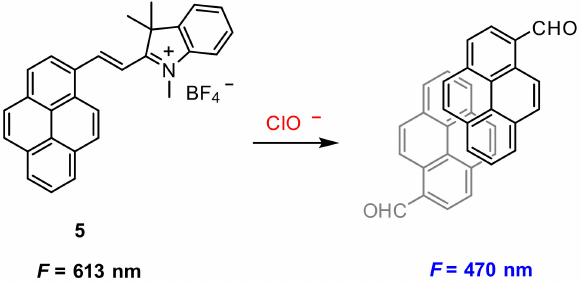
Figure 12. Chemical structure of probe 5 and its excimer response to OCl − . Bioimaging of OCl − in live cells was performed in stained HeLa and Raw 264.7, respectively. Upon ClO − loading and incubation for 2 h, blue fluorescence signal was observed, suggesting the internalization of 5 and its reaction with the preloaded ClO − (Figure 13).